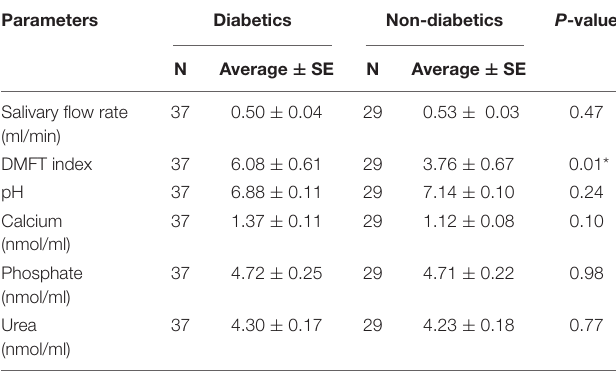
TABLE 2 | Salivary parameters in children with type 1 diabetes mellitus and healthy children. Parameters